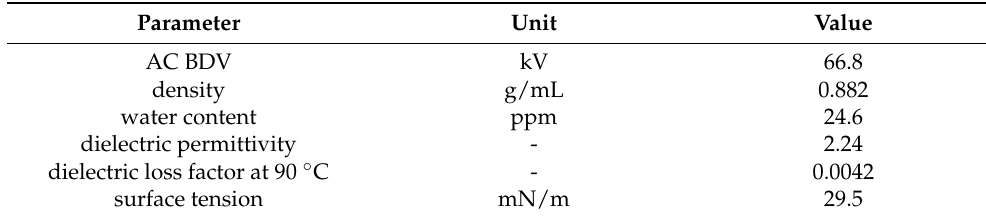
Table 1. Selected characteristic parameters of the tested mineral oil.